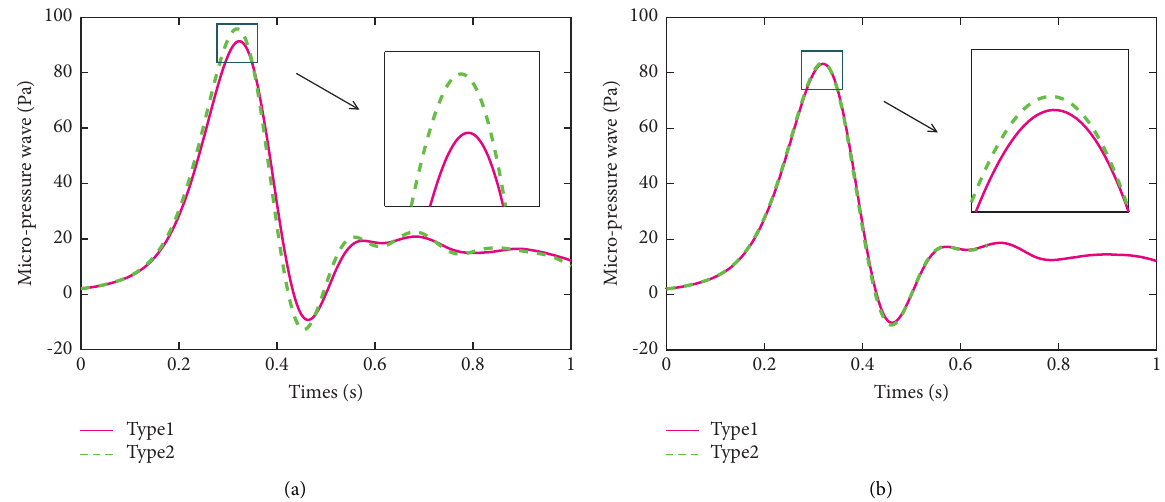
Figure 13: Comparison of the micropressure wave at M 1. (a) Linings at the tunnel entrance. (b) Linings at the tunnel exit.